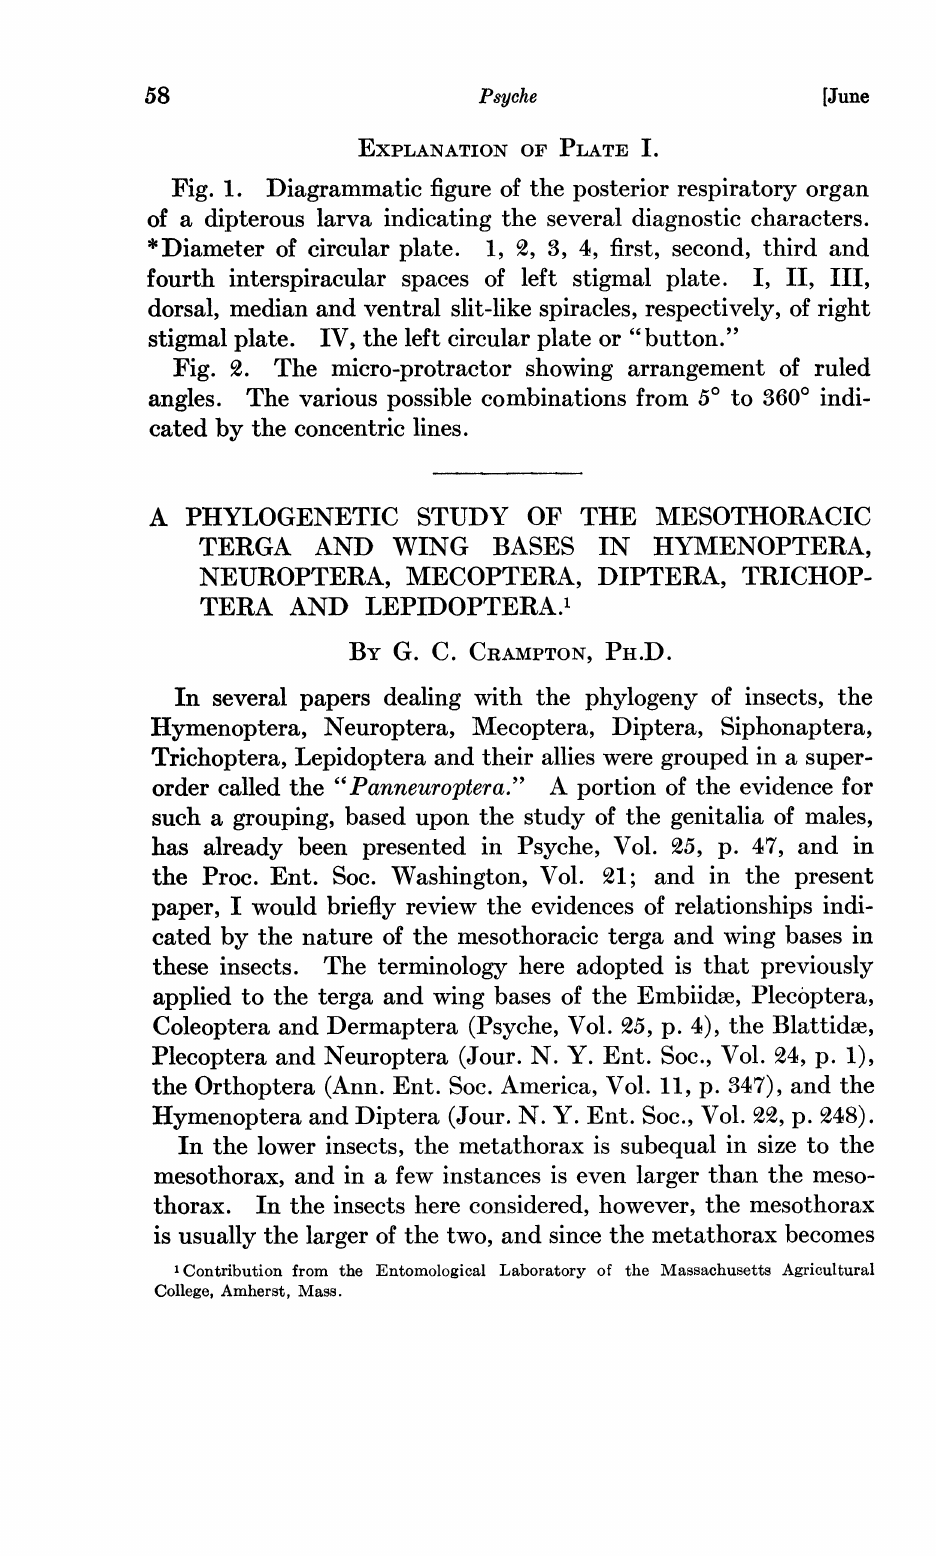
Fig. 1. Diagrammatic figure of the posterior respiratory organ , of a dipterous larva indicating the several diagnostic characters. *Diameter of circular plate. 1, 8, 4, first, second, third and fourth interspiracular spaces of left stigmal plate. I, II, III, . dorsal, median and ventral slit-like spiracles, respectively, of right stigmal plate. The micro-protractor showing arrangement of ruled angles. The various possible combinations from 5 to 360